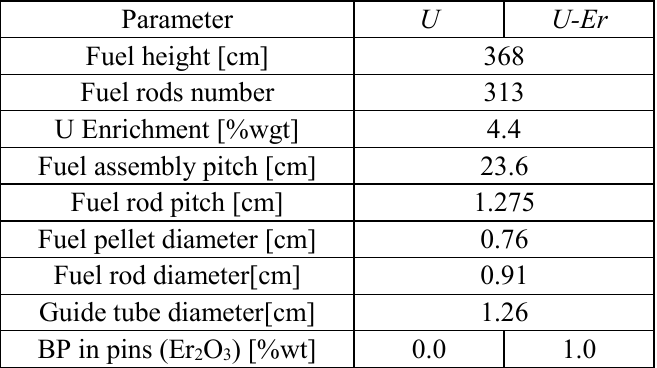
Table I: Main characteristics of the FA proposed. Details can be gathered from [9].